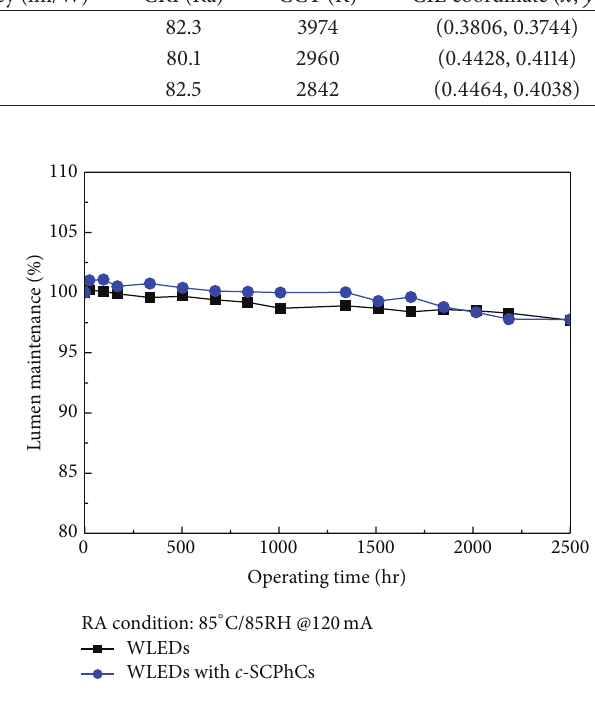
Figure 5: Degradation of lumen maintenance for the two types of WLEDs after the 85 ∘ C/85 RH with 120